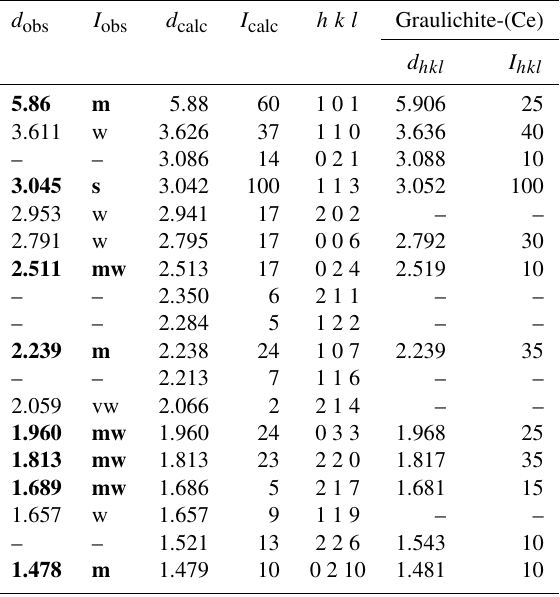
Table 2. X-ray powder diffraction data ( d in Å) for graulichite-(La). Intensity and d hkl were calculated using the software PowderCell 2.3 (Kraus and Nolze, 1996) on the basis of the structural model given in Table 4. Only the reflections with I calc > 5 are given, if not observed. The eight strongest reflections are shown in bold. For the sake of comparison, the X-ray powder diffraction data of graulichite-(Ce) (Hatert et al., 2003) are